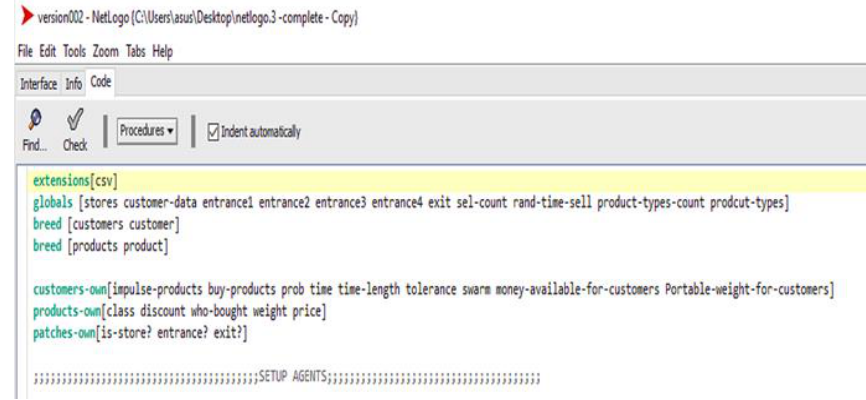
Fig. 7. A view of the definition of variables.